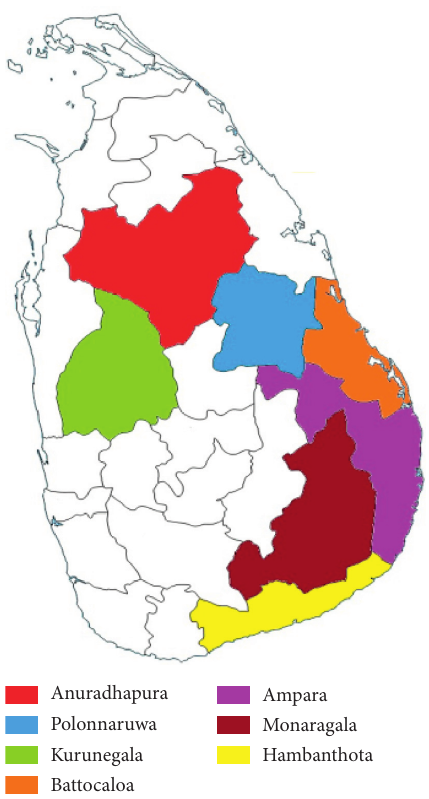
Figure 1: Study Table 1: Paddy yield in the study areas.